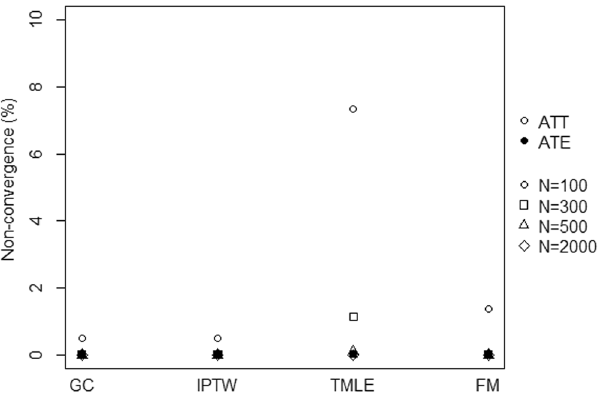
Figure 2. Percentage of simulation iterations which did not converge according to the